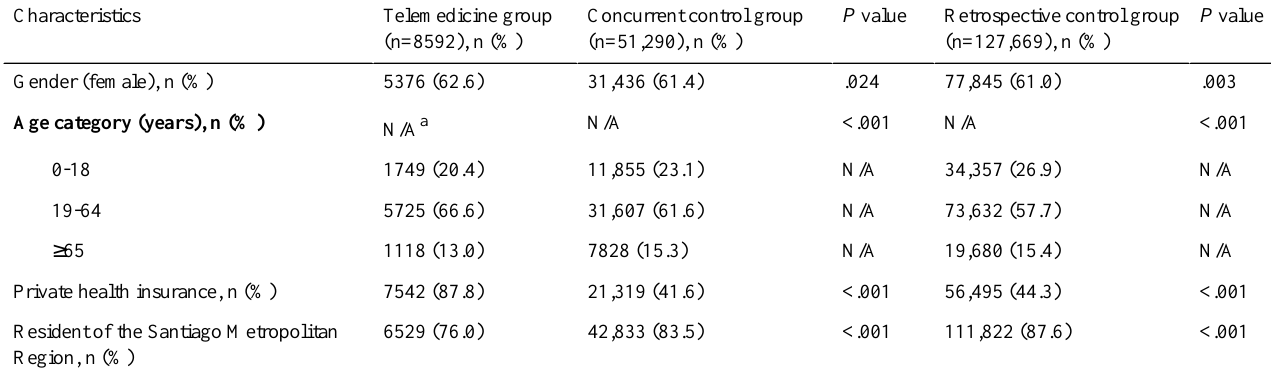
Table 1. Demographic characteristics of patients receiving care through telemedicine compared to patients from concurrent and retrospective control